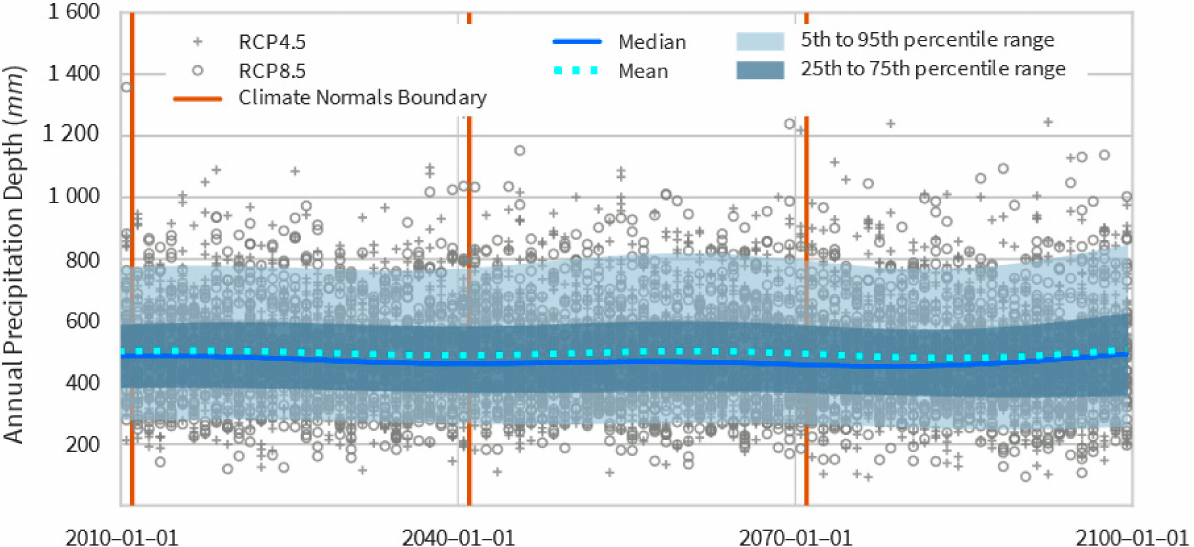
Figure 5. LOCA downscaled ensemble GCM annual precipitation depth results. An integrated cone of uncertainty for future precipitation is superimposed on weather results from two emissions scenarios. Average annual precipitation depth is flat from 2011–2100, denoting no significant change across the simulation